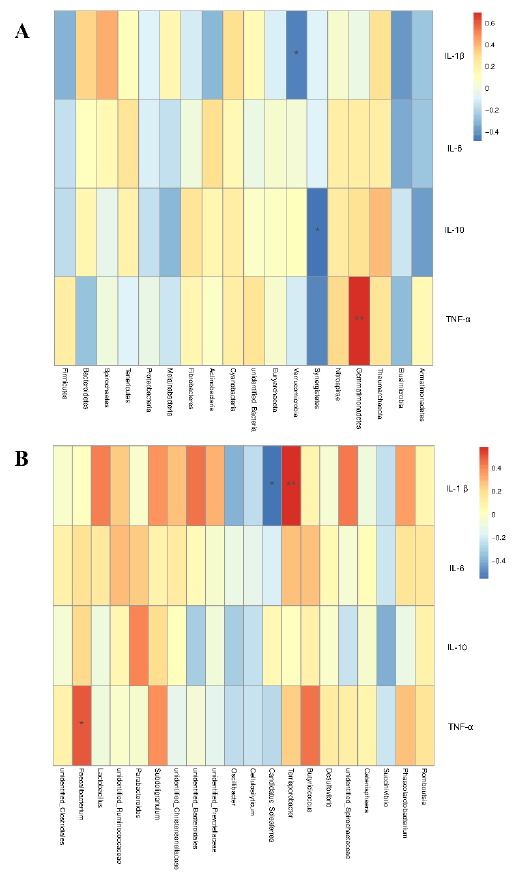
Figure 7. Heat map of the Spearman r correlations between gut microbiota and plasma cytokines in lactation sow at the phylum level ( A ) and the genus level ( B ). n = 10. * is significantly different ( p < 0.05). ** are significantly different ( p < 0.01) (following the Spearman correlation analysis).